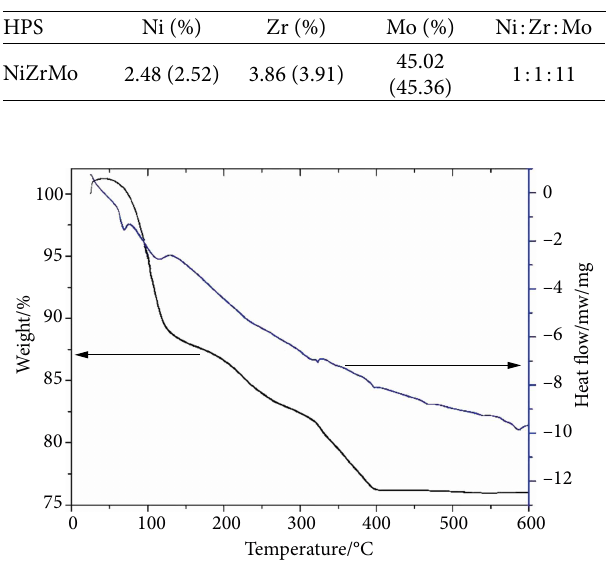
Figure 1: TGA/DSC curve of NiZrMo.